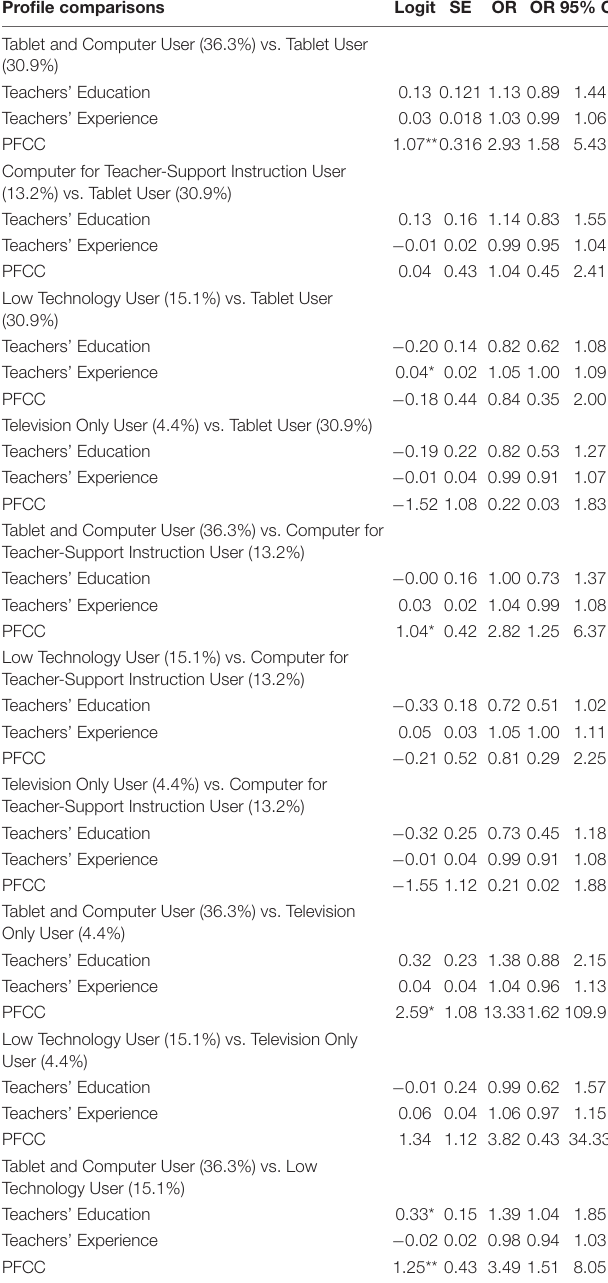
TABLE 6 | Multinomial logistic regression analyses for teacher and program characteristics predicting membership into one of the five latent classes. Profile